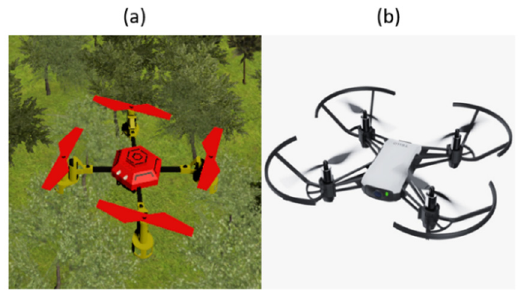
Figure 4. Images of a drone used in this system: ( a ) a drone used in the virtual environment and ( b ) a drone used (DJI-Tello) in the real environment.